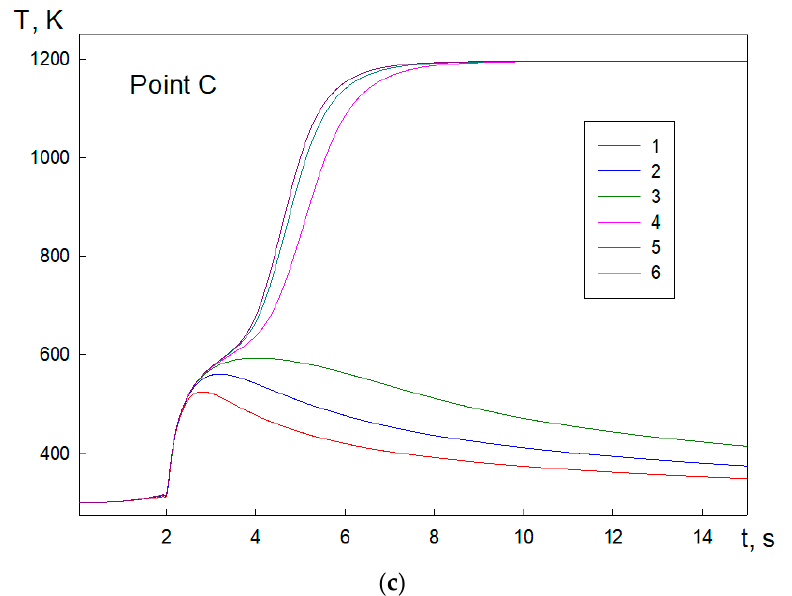
Figure 8. Temperature change over time: ∆ t = 2 s, d = 5.5 mm, h = 6.5 mm, 1 —L = 19 mm, 2 – L = 29, 3– L = 39, 4 – L = 49, 5 – L = 59, 6 – L = 69.